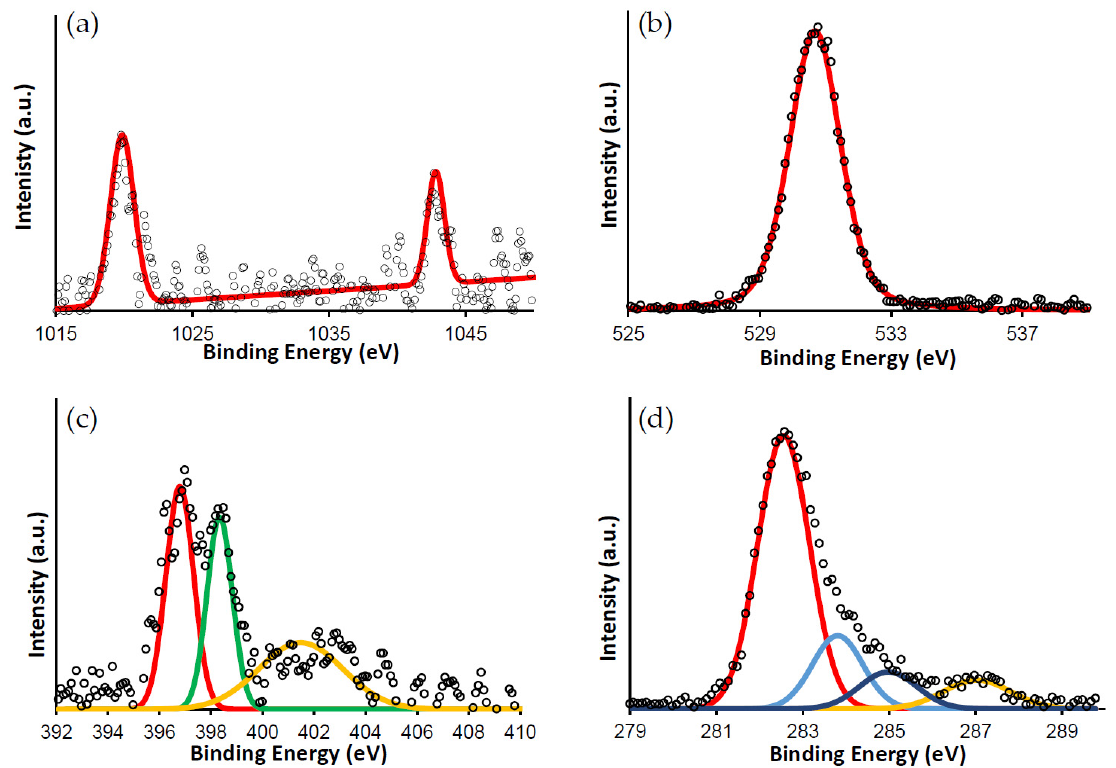
Figure 5. XPS spectra of the PPc blend deposited on glass substrate ( a ) Zn-2p, ( b ) O-1s, ( c ) N-1s, ( d ) C-1s.